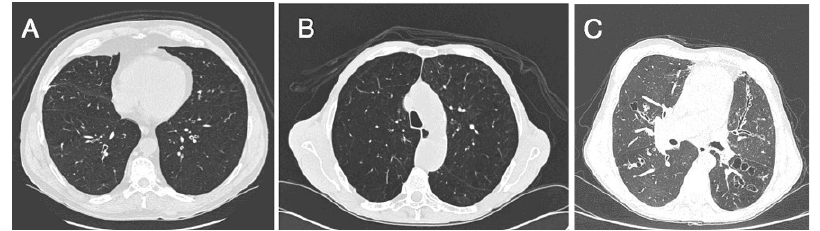
Figure 1 - Tomographic cross-sections. A) Asthmatic patient with diffuse bronchial wall thickening. B) COPD patient with extensive areas of centrilobular emphysema predominantly in the superior lung fields. C) Patient with cystic and varicose bronchiectasis characterized by dilation and thickening of